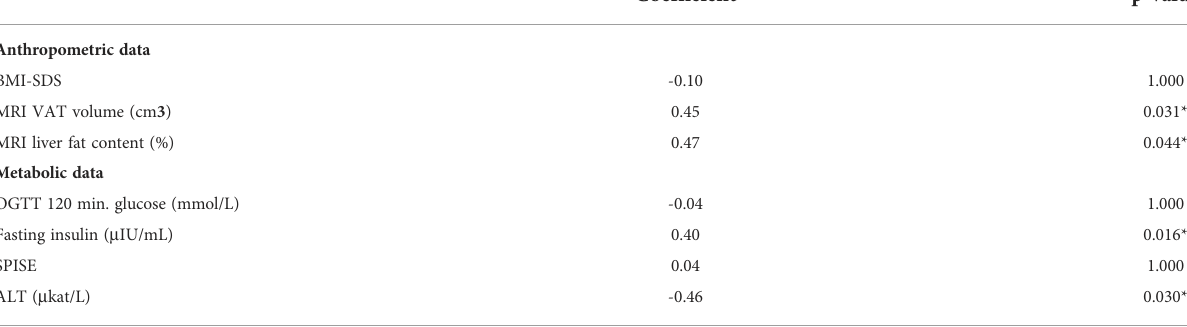
TABLE 3 Multivariate regression analysi with standardized coef fi cients: predictor of glucagon in a pediatric cohort with overweight/obesity (n = 73) matched for BMI-SDS (R2 = 0.336), correct by Bonferroni-Holm